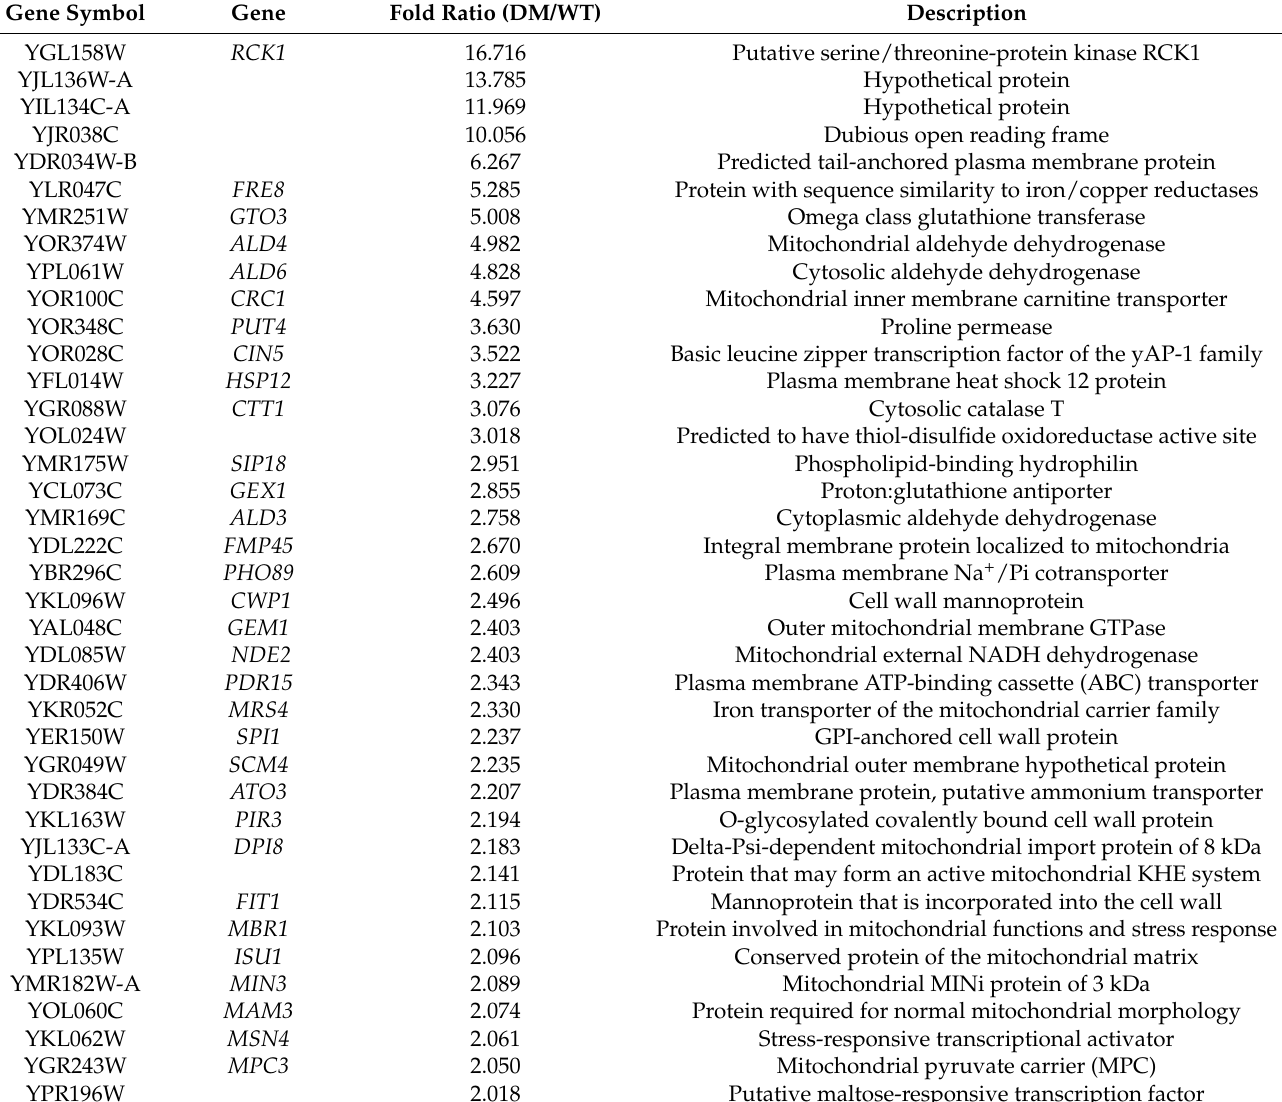
Table 1. Upregulated genes in DaMDHAR -expressing yeast cells to FT